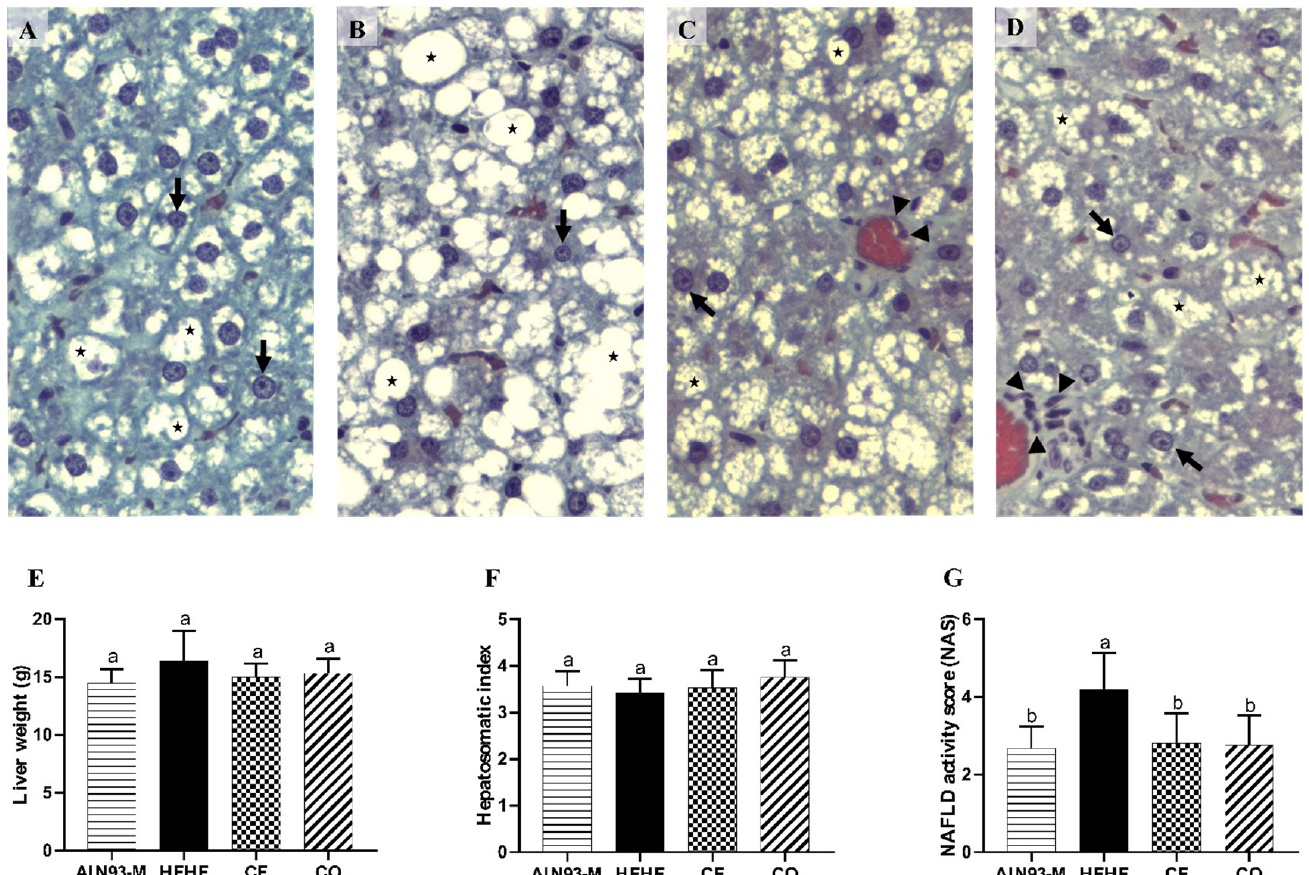
Figure 7. Representative histopathological photomicrographs of liver sections after 10 weeks od experiments in the groups: ( A ) AIN-93M (28.7% of lipid droplets in the liver); ( B ) HFHF: 4% of soybean oil, 31% lard, and 20% fructose) (animals showed 17.9% of lipid droplets in the liver); ( C ) chia flour: HFHF with 4% soybean oil replaced by chia flour (CF) lipid (14.7% of chia flour) (15.5% of lipid droplets in the liver); ( D ) chia oil (CO): HFHF with 4% of soybean oil replaced by 4% of chia oil (12.9% of lipid droplets in the liver); ( E ) liver weight; ( F ) hepatosomatic index; ( G ) NAFLD activity score (NAS). Gomori Trichrome Stain. ( → ) Hepatocyte nucleus; (>) lipid vesicles; ( ★ ) blood vessels. Bar = 50 µm. Values of liver weight ( n = 10), hepatosomatic index ( n = 8), and NAS ( n = 8) are represented by average and standard deviation The difference between the averages was analyzed by the one-way ANOVA test followed by the Newman–Keuls post-hoc test. Different letters indicate significant statistical differences ( p < 0.05).